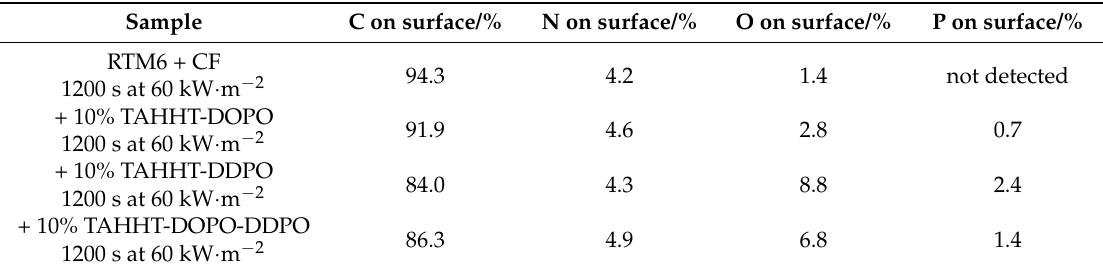
Table 8. Concentrations of elements at the fiber surface after irradiation.